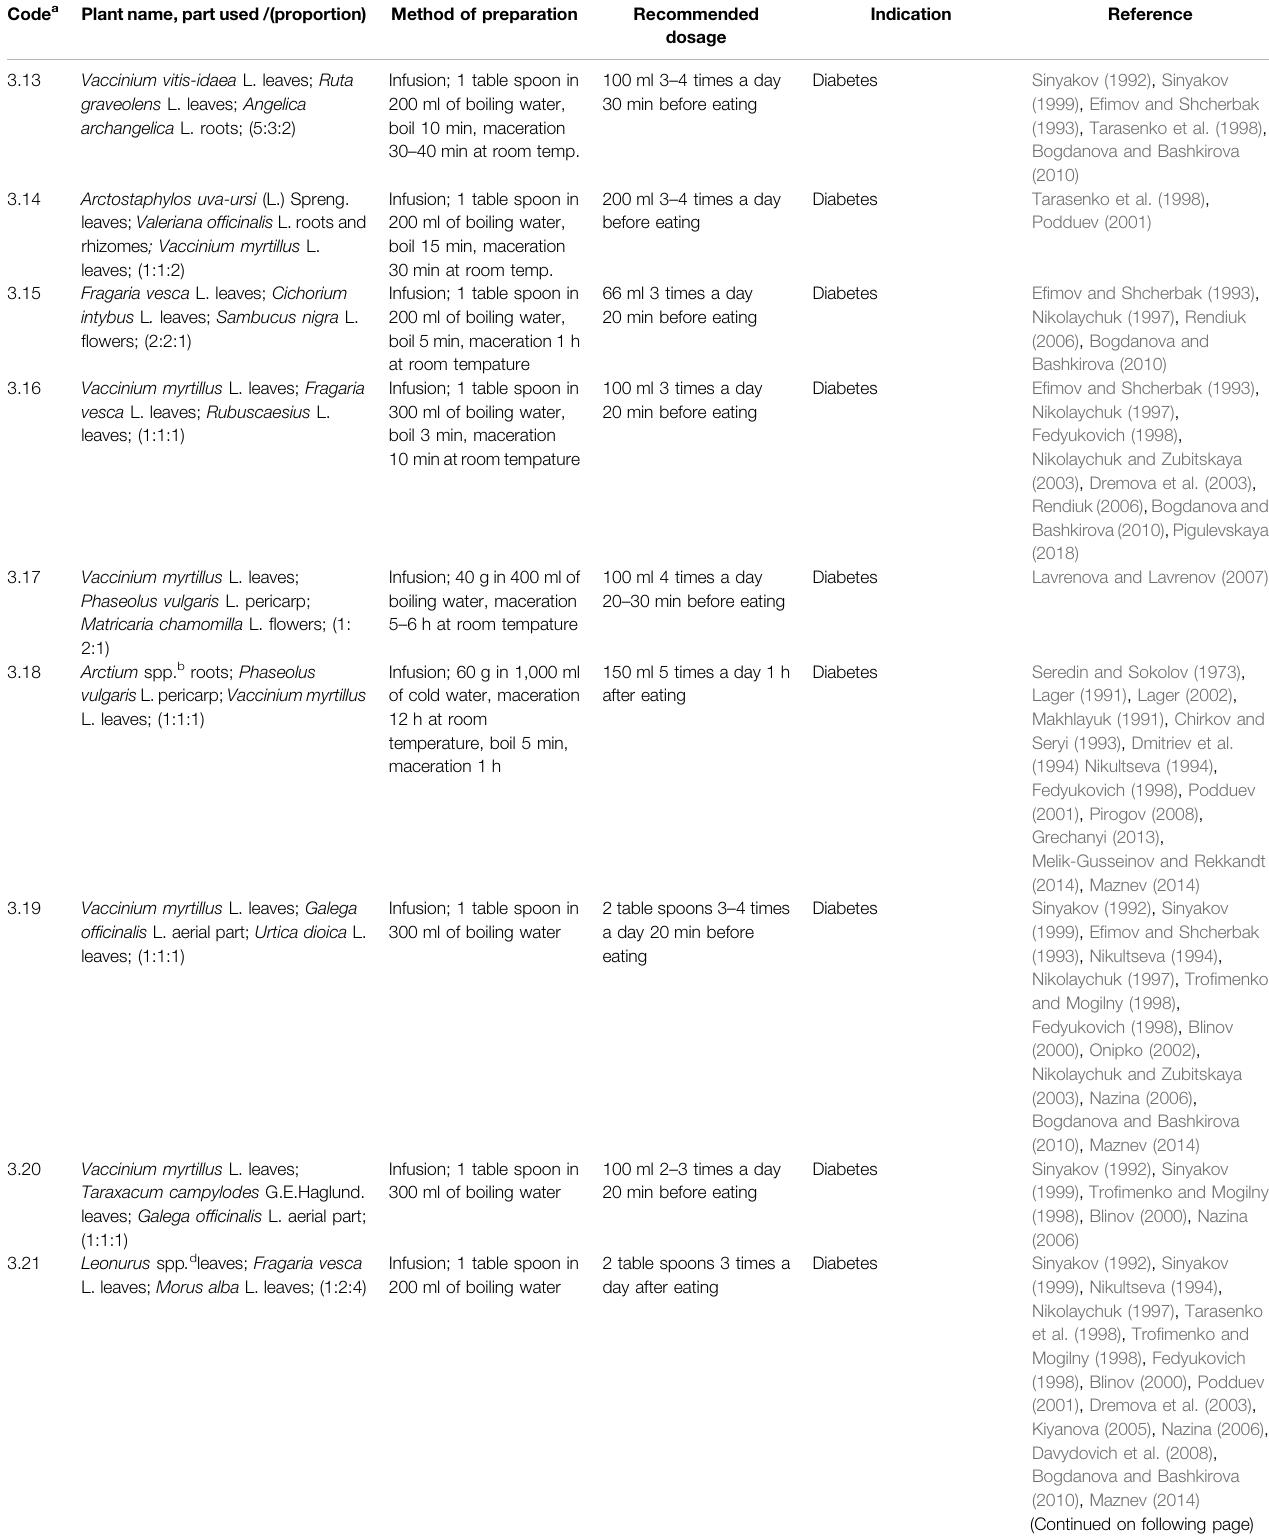
TABLE 1 | ( Continued ) The list of medical species used for the management of diabetes and related disorders in Russia. Code a Plant name, part used /(proportion) Method of